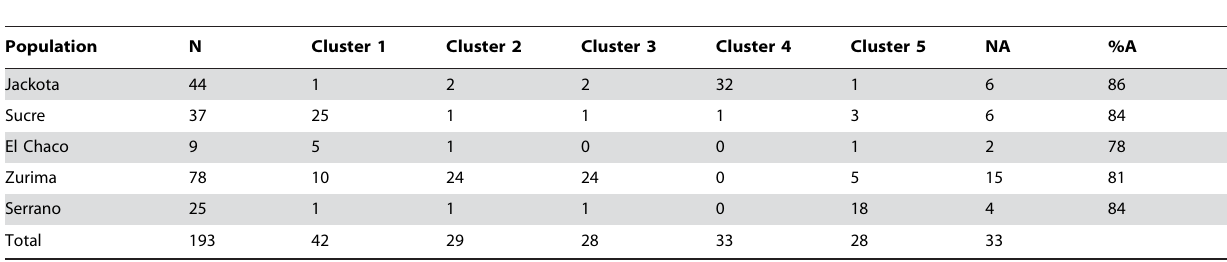
Table 3. Assignment of individuals from 5 localities to genetic populations through Bayesian analysis.